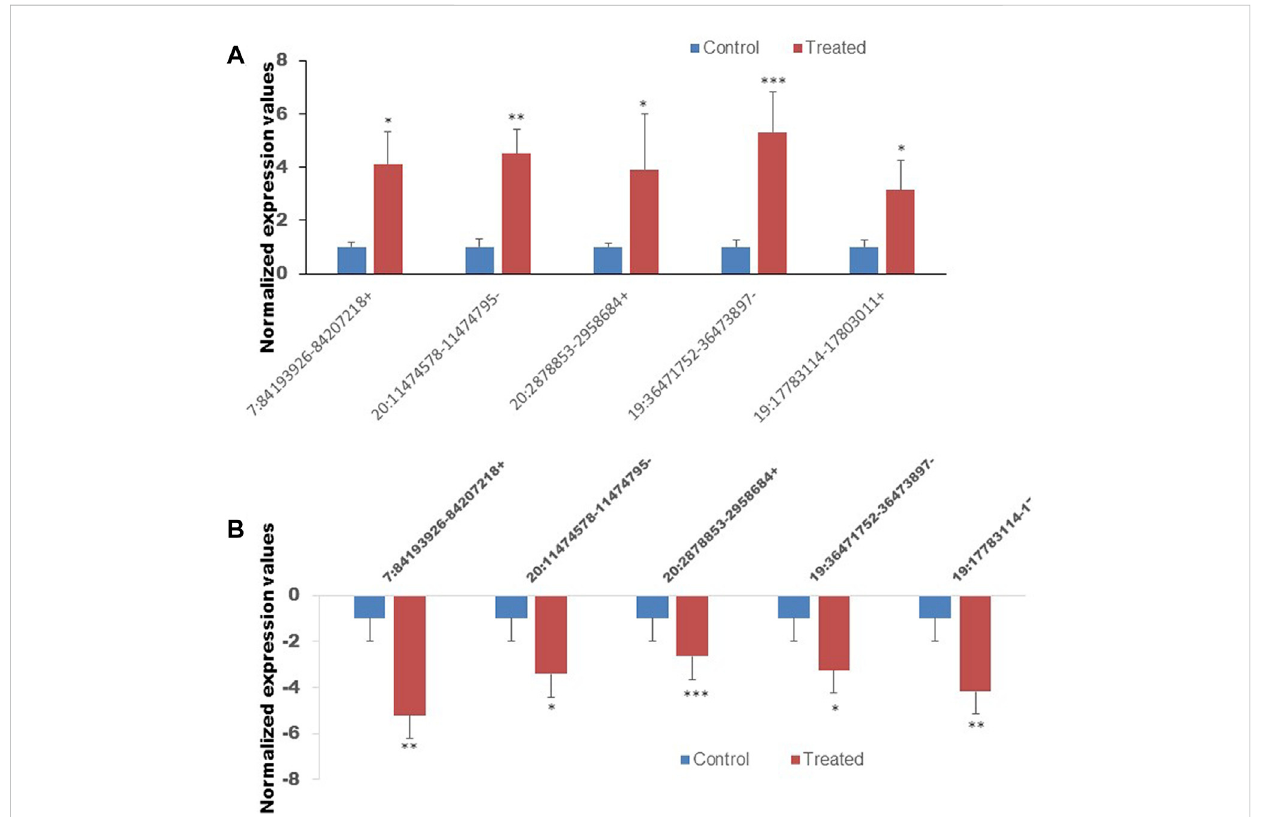
FIGURE 9 The expression of ten circRNAs con fi rmed by the quan-titative real-time reverse transcription-polymerase chain reaction (qRT-PCR). (A) The expression of fi ve selected upregulated circRNAs. (B) The expression of fi ve selected downregulated circRNAs. * p < 0.05, ** p < 0.01, *** p < 0.001. The primer sets that were used to amplify the selected circRNAs are enlisted in Table